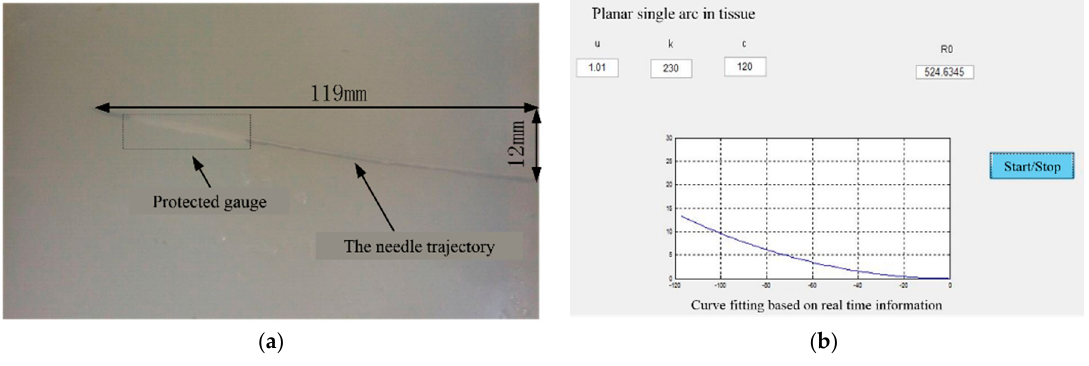
Figure 16. ( a ) Experiment of needle in tissue; ( b ) experiment of needle in the computer image.